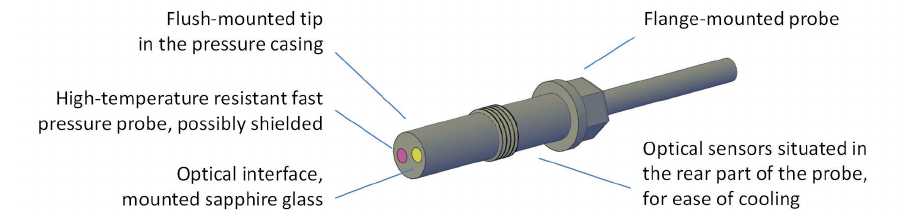
Figure 3. Proposed tentative design of the RCP for industrial